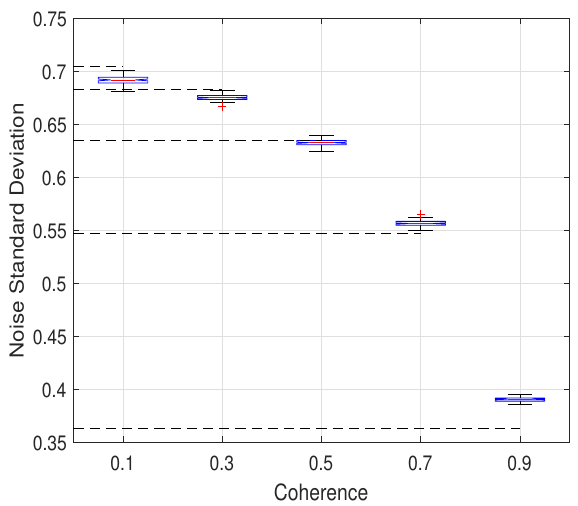
Figure 6. Boxplot of 100 noise level estimation experiments corresponding to each coherence (the black dotted line is the mean of true value).